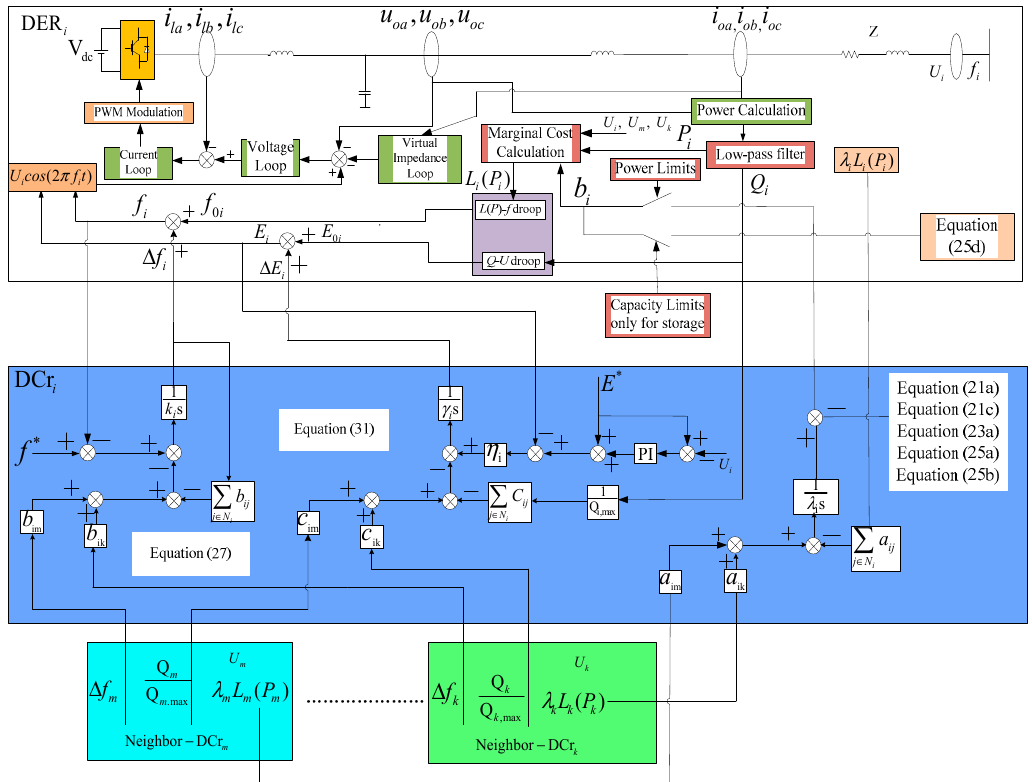
Figure 2. Block diagram of the overall control architecture for a single distributed energy resource (DER).